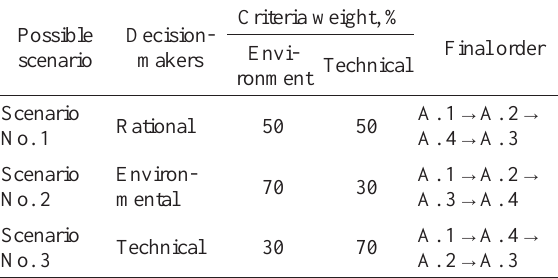
Table 5. Final performance of each alternative compare to different decision maker